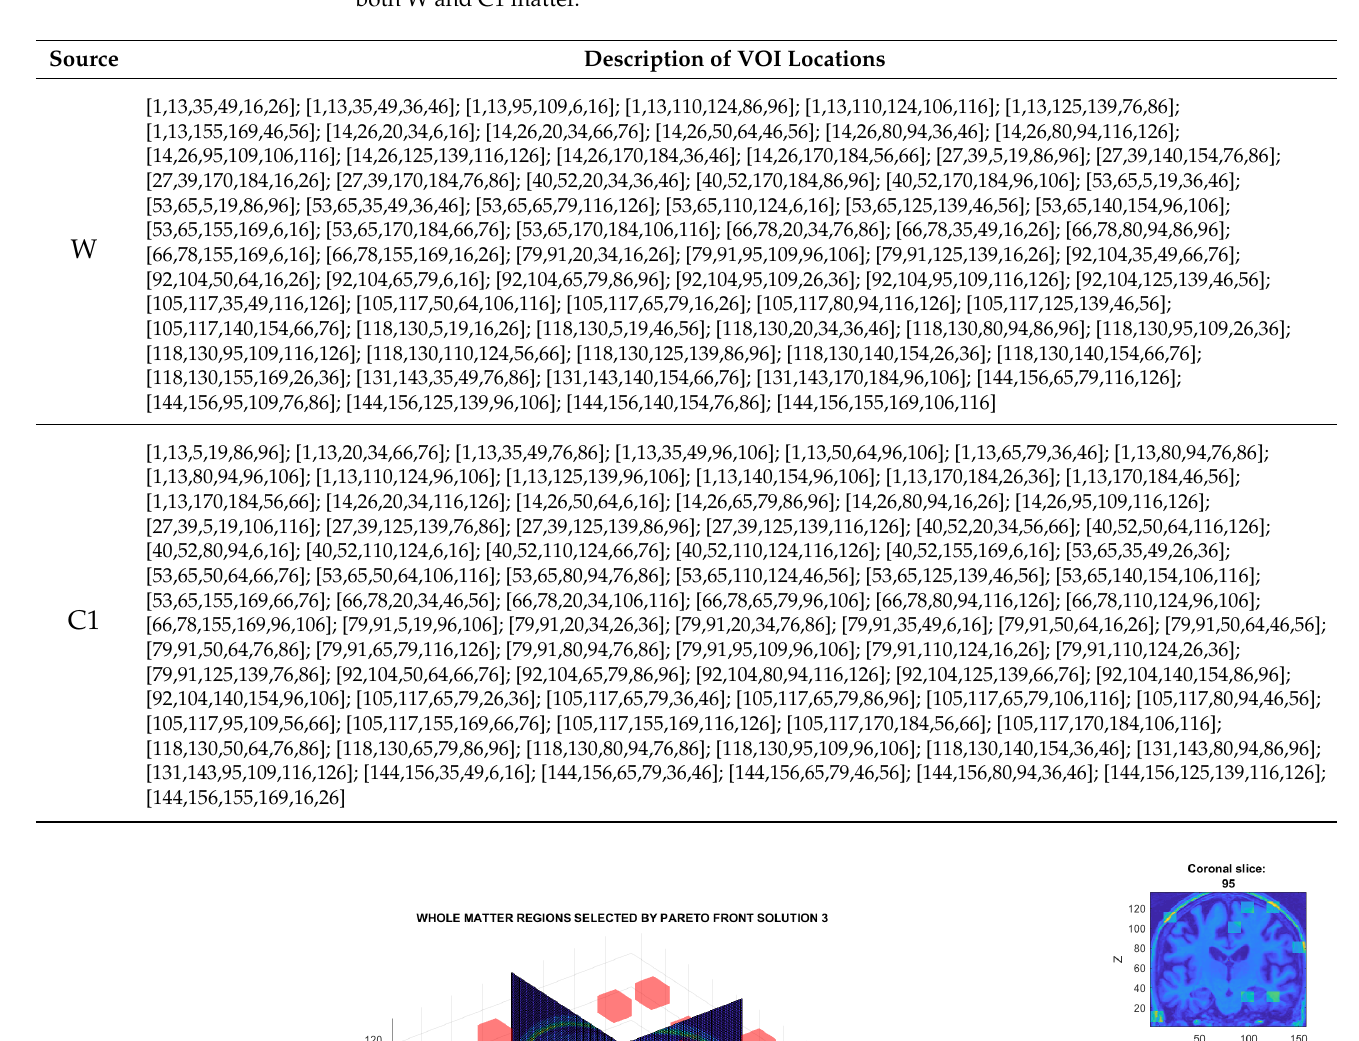
Table 6. Description of the spatial location (each VOI being described by its six integers [xmin,xmax,ymin,ymax,zmin,zmax]) for the third solution obtained by the MOE algorithm, for both W and C1 matter.